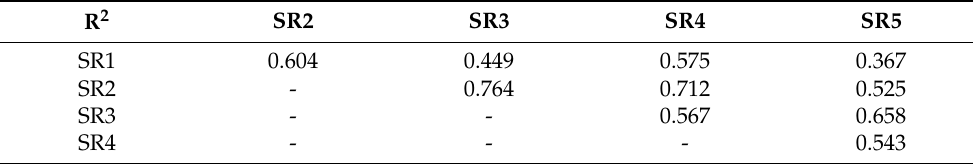
Figure 6. True color image of the Landsat-8 data acquired on 3 January 2015. The five extracted Scheme 1. represents subregion 1, SR2 represents subregion 2, etc. SR2 is the sand excavation area. Table 4. The correlation coefficient of the TSM concentrations in different subregions (all images). SR1 represents subregion 1, SR2 represents subregion 2, etc. All the correlation coefficients passed the significance test (N = 194, p < 0.01).